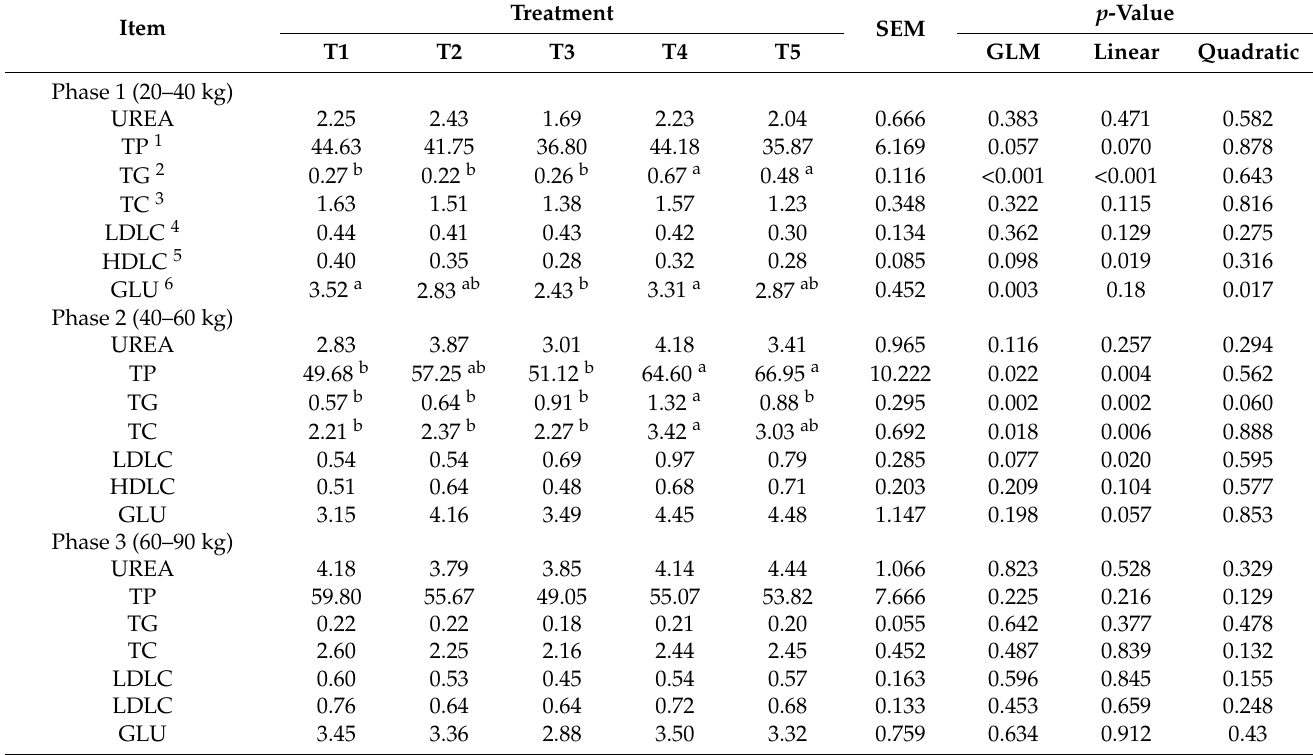
Table 5. Effect of dietary SID lysine levels on serum metabolites of Baqing pigs at 20–90 kg (mmol/L).